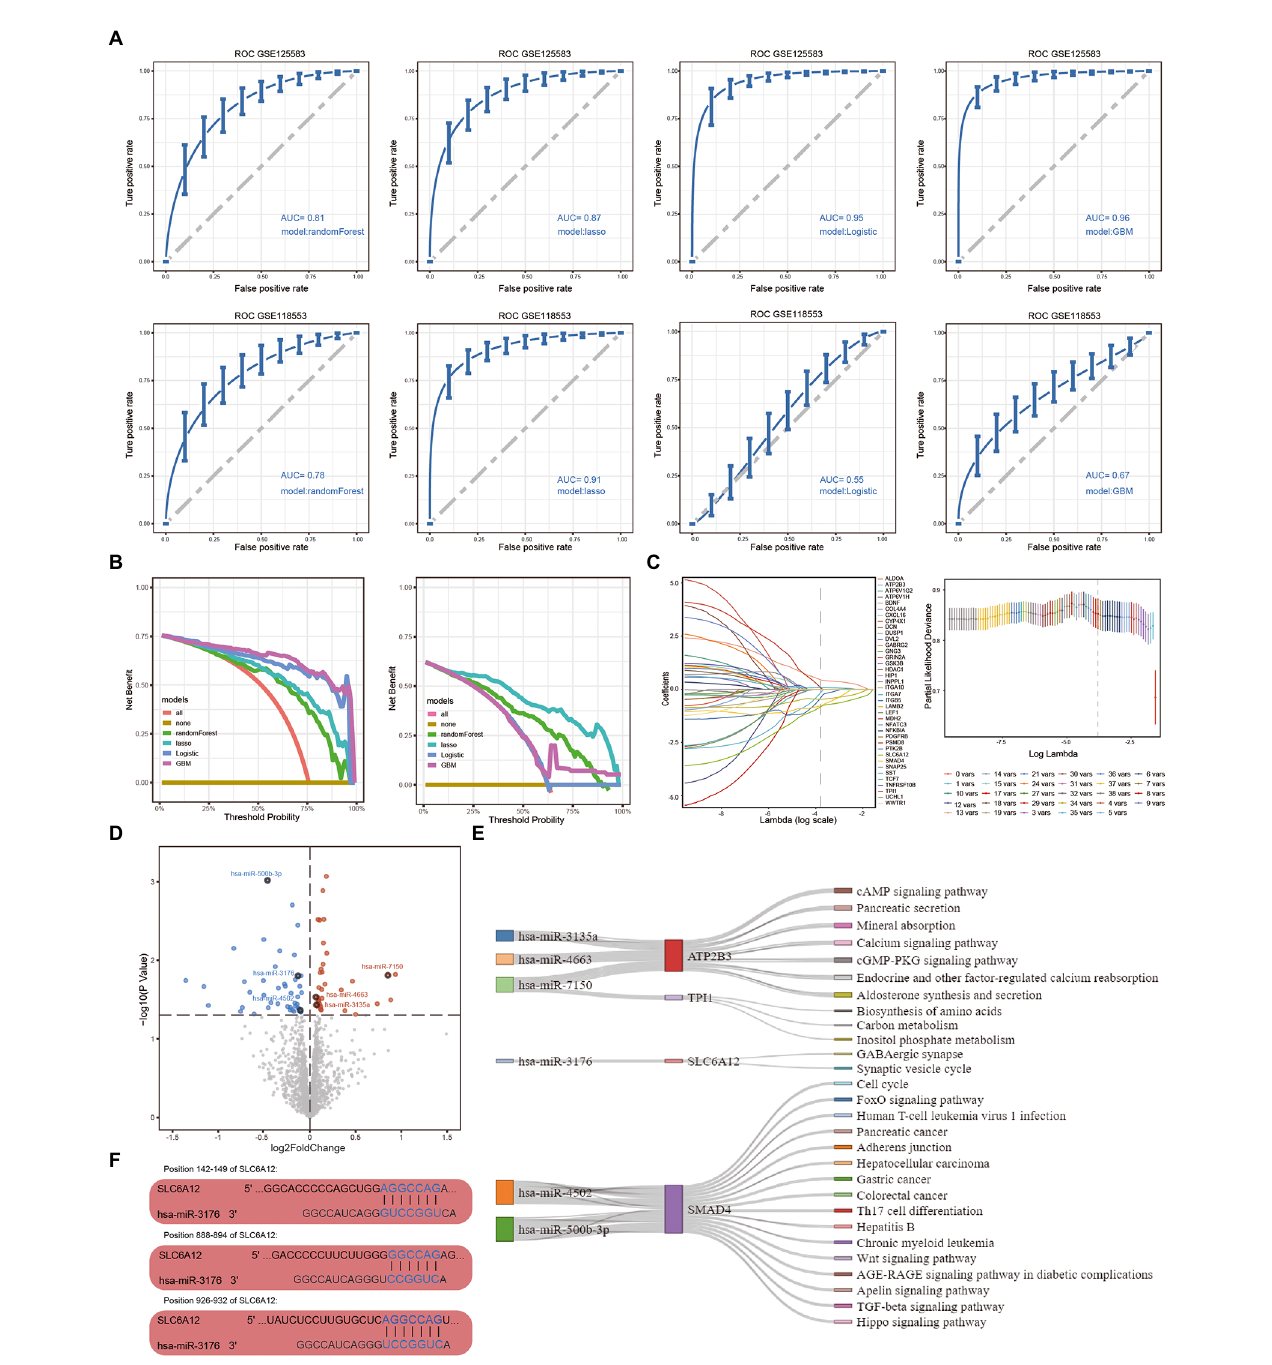
FIGURE 3 Optimal diagnostic model and feature genes obtained in Alzheimer’s disease (AD). (A) ROC curves showing the diagnostic performance of four models in GSE125583 and GSE118553, including random forest, LASSO, logistic regression, and GBM models. (B) Decision curve analysis of four models in GSE125583 and GSE118553. (C) The feature genes were identified by the LASSO model. (D) Up/downregulated DEmiRs in GSE157239. Red indicates upregulated DEmiRs, blue indicates downregulated DEmiRs. (E) Feature genes regulated by DEmiRs were involved in pathways. (F) Binding sites of the DEmiR to the hub gene. Blue font shows the position of the combination. GBM, gradient boosting machine; LASSO, least absolute shrinkage and selection operator; ROC, receiver operating characteristic curve; AUC, area under the curve; DEmiRs, differentially expressed